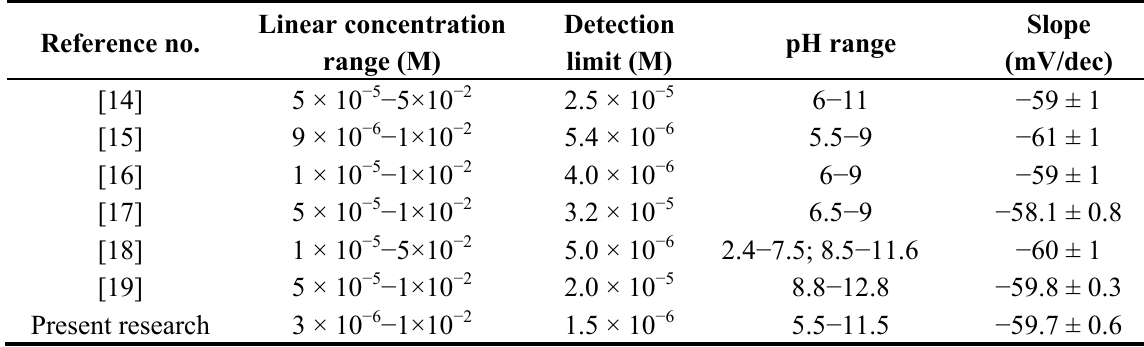
Table 4. Comparative potentiometric characteristics of diclofenac–selective sensors. Reference